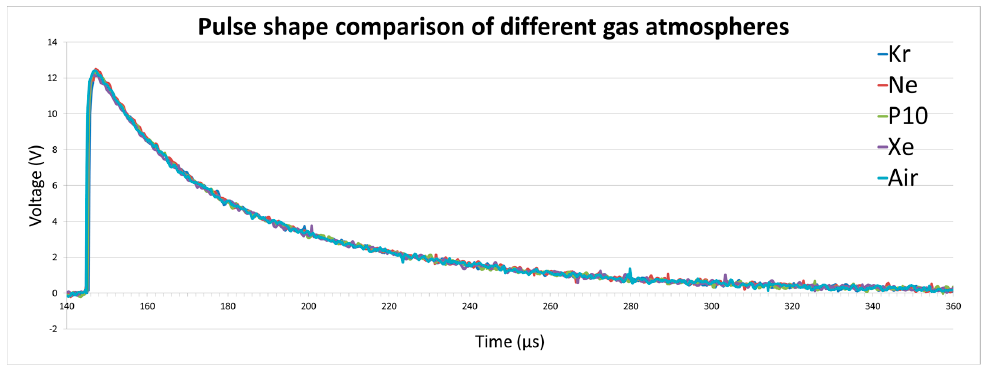
Figure 7. Pulse shape comparison of different gas atmospheres.